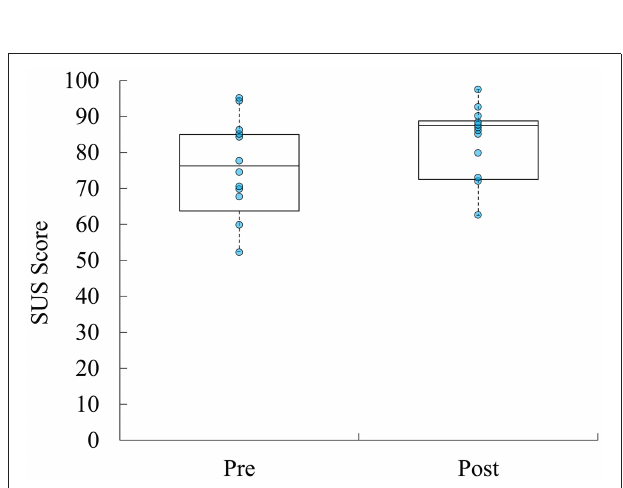
FIGURE 4 | Boxplots overlaid with raw data of self-reported usability of ADAPT-MP system over the course of the